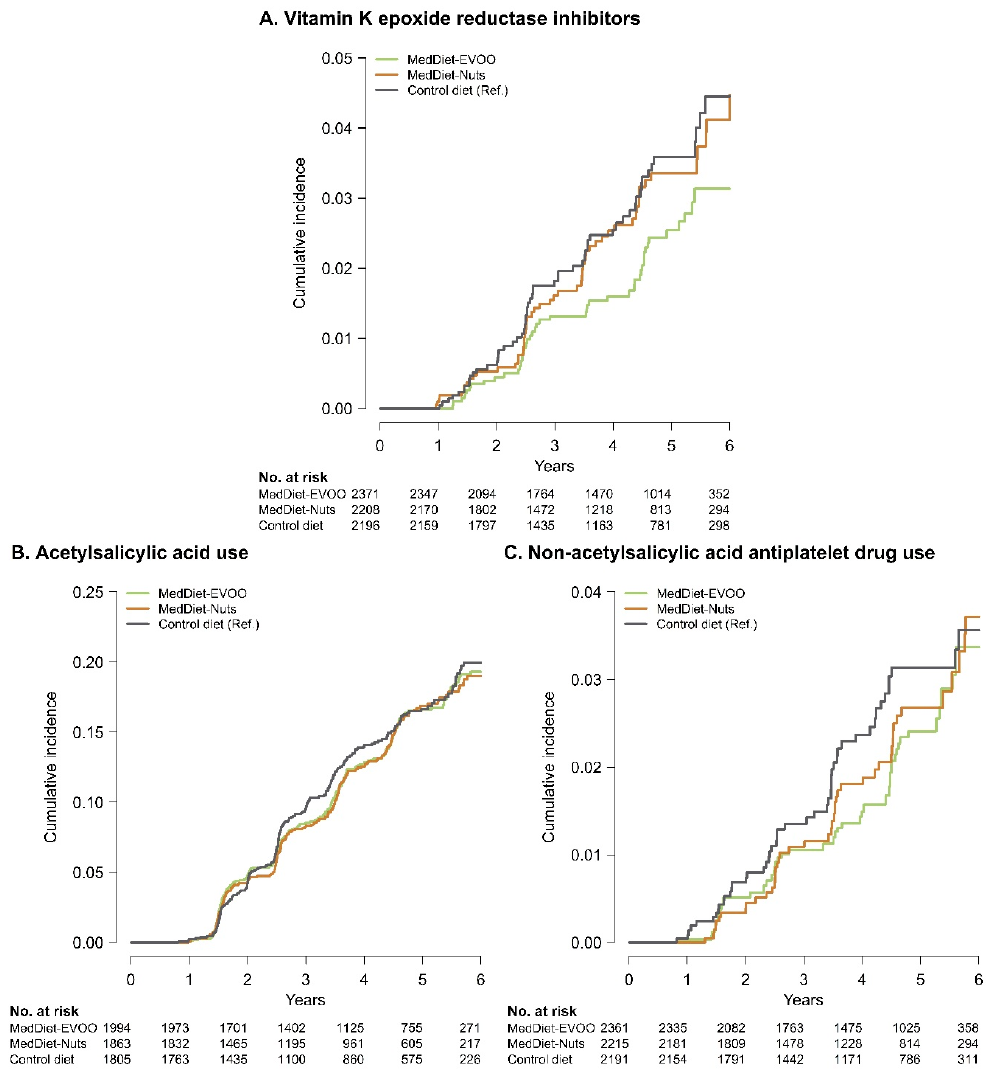
Figure 2. Incident cases of initiation of use of vitamin K epoxide reductase inhibitors ( A ), acetylsalicylic acid as antiplatelet agent ( B ), and non-acetylsalicylic antiplatelet drugs ( C ) in the three intervention groups by Kaplan–Meier cumulative incidence curves. Kaplan–Meier curves weighted control group based on: age, sex, recruitment site, educational level, diabetes, hypercholesterolemia, hypertriglyceridemia, smoking, leisure-time physical activity, body mass index, alcohol consumption,